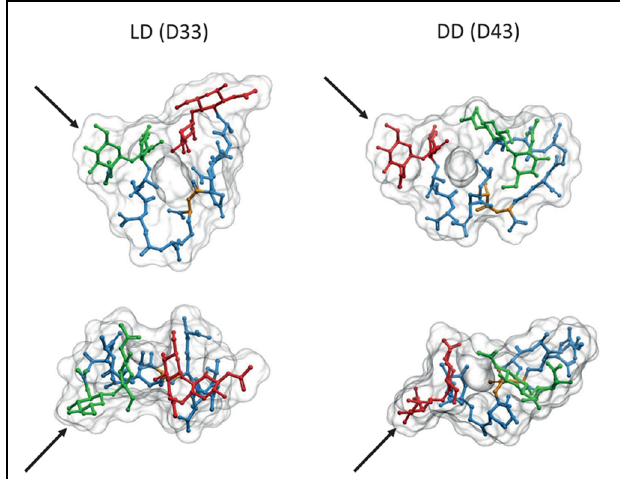
FIGURE 4 | Comparison of LD and DD cross-linked PG dimers. 3D representations of molecules from the LD cross-linked bis -disaccharide-tripeptide (D33), and the DD cross-linked disaccharide-tetrapeptide-disaccharide-tripeptide (D43) dimers were generated as described in Figures 1 and 2 . Upper images correspond to a transversal view, and lower images to a view from above. Each pair was oriented according to the GlcNAc residues indicated by the black arrows. Red, green, and blue designate the disaccharide for the donor moiety, the disaccharide for the acceptor moiety and the stem peptide, respectively. Yellow highlights the position of the cross-link. Note the inverted orientation predicted for the donor and acceptor